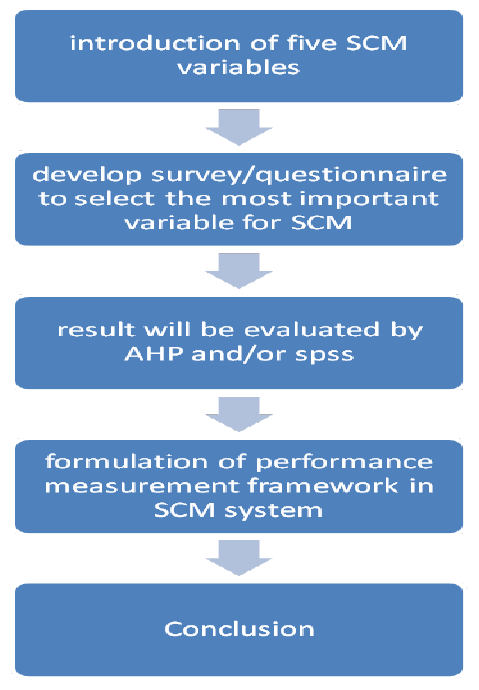
Figure 2: Research